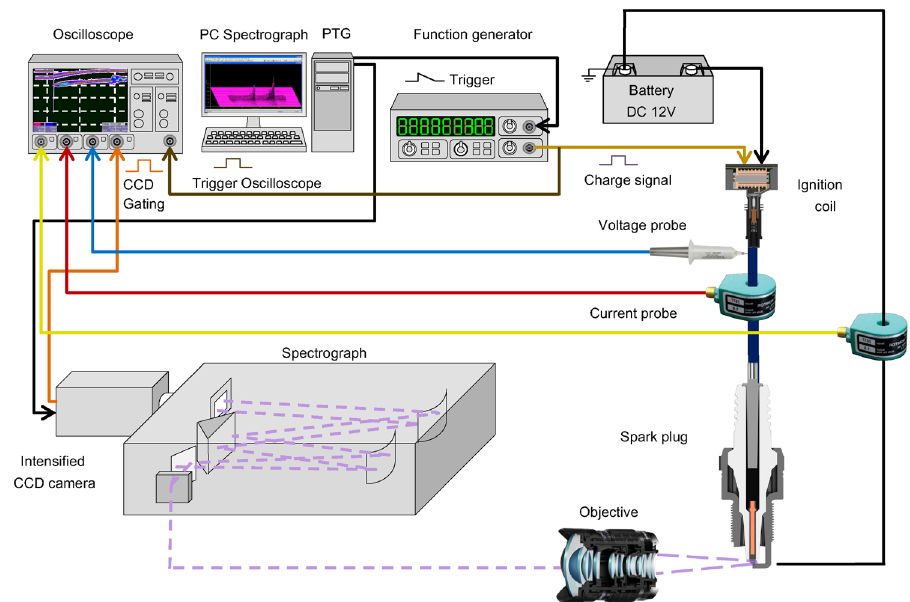
Fig. 2 Schematic of the electric and spectroscopic